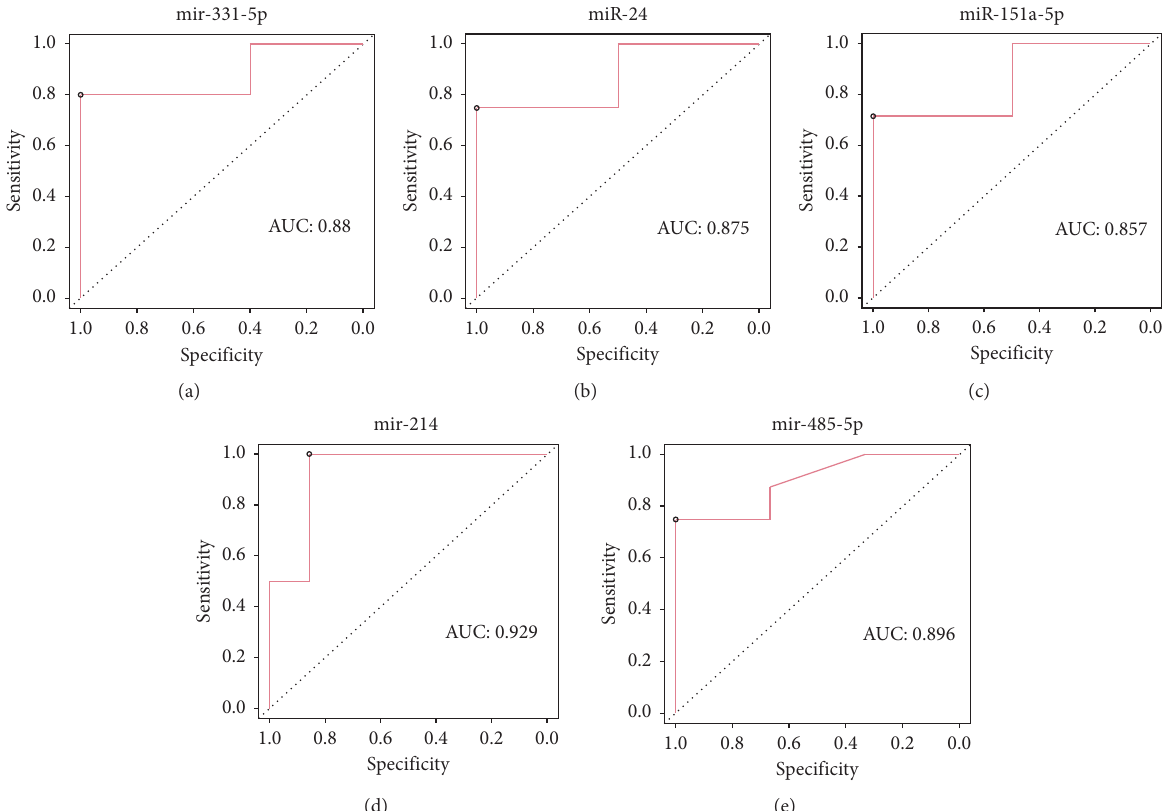
Figure 3: Receiver operation characteristic curve (ROC curve) of the microRNA (miRNA) expressed in serum and cerebrospinal fluid (CSF) exosomes which is significant in Parkinson’s disease (PD) compared to neurodegenerative disorder (ND) and